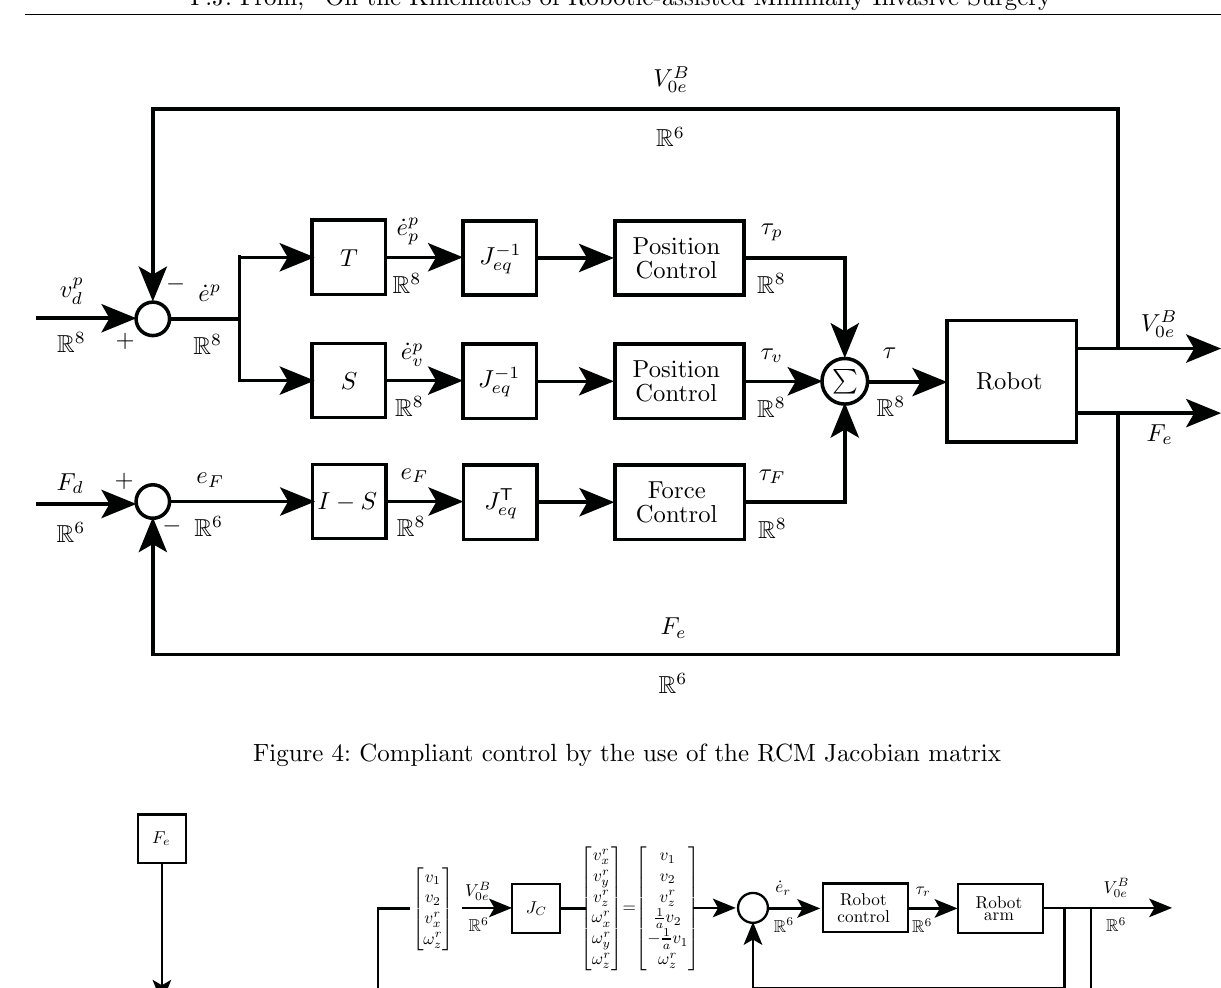
) − 1 guarantees that the insertion ep